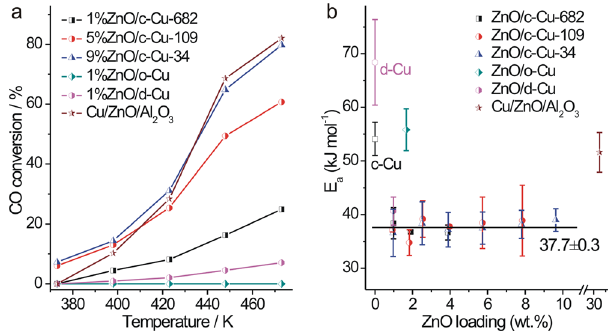
Fig. 3 Catalytic performance in WGS reaction. a Catalytic performance of representative ZnO/Cu and commercial Cu/ZnO/Al 2 O 3 WGS catalysts for the WGS reaction; b Apparent activation energies (E a ) of various catalysts as a function of ZnO